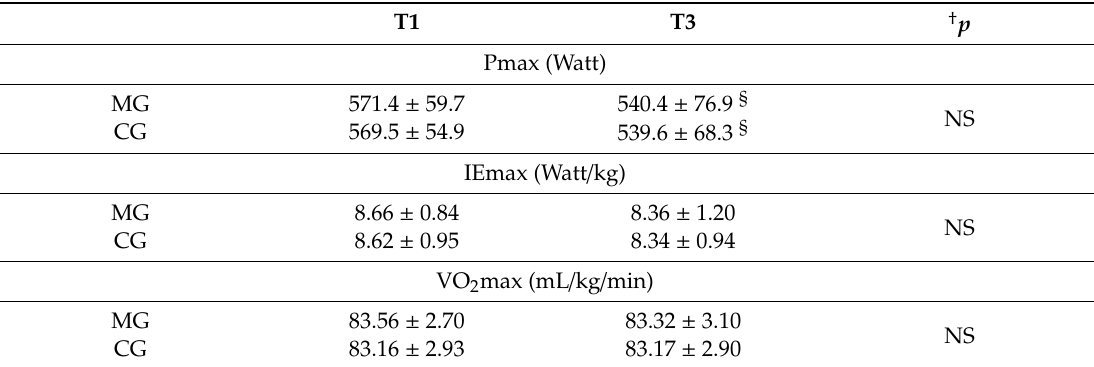
Table 2. Parameters obtained at the ergometry test in the magnesium supplemented group (MG) and control group (CG) at the beginning (T1) and at the end of the study (T3). T1 T3 †